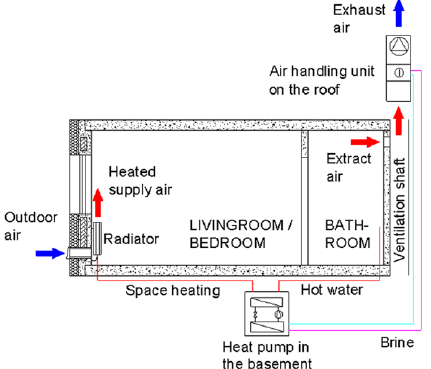
Fig. 2. The principle of heat recovery of centralised exhaust ventilation system with exhaust air heat